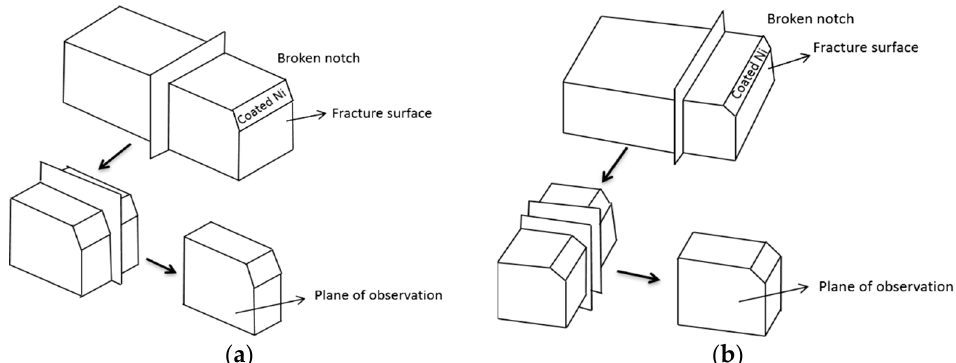
Figure 3. Observation plane positions of fracture propagation for Charpy impact and DWTT samples: ( a ) fracture propagation plane of Charpy impact, ( b ) fracture propagation plane of DWTT.